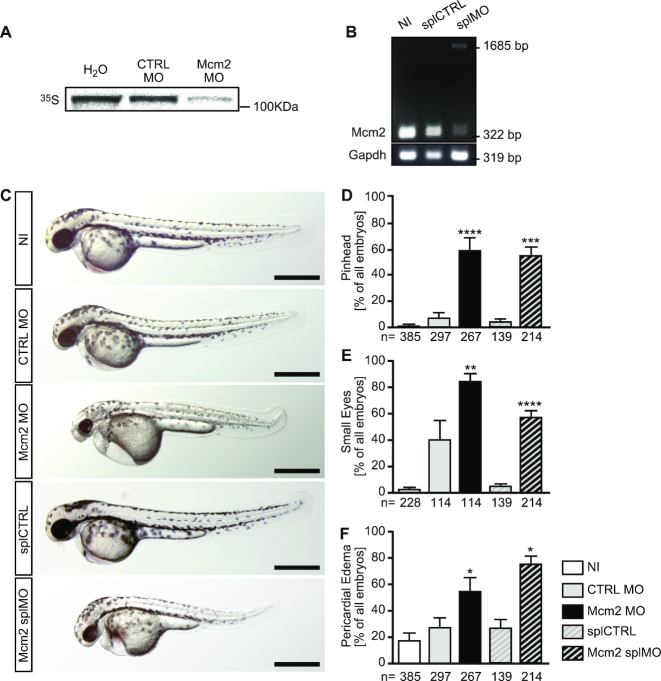
Morphological analysis of zebrafish lacking Mcm2. (A) Autoradiogram to show the binding efficiency of the Mcm2 MO. In vitro translation of Mcm2 was done in the presence of CTRL (CTRL MO) and translation blocking MO (Mcm2 MO) using a cell-free reticulocyte lysate and 35S-labeled methionine. As template, pCS2+ containing parts of the 5′-UTR fused to the ORF of Mcm2 was used. n = 3 MO binding tests (in triplicate). (B) RT-PCR of non-injected (NI), control injected (splCTRL) and splice blocking injected (splMO) embryos at 24 hpf. In embryos with Mcm2 splMO the original band at 322 bp partially disappeared. Instead a second band at 1685 bp could be detected, which contained parts of intron 2. n = 2 independent experiments. (C) Live images of zebrafish at 48 hpf. Scale bars: 500 μm. (D) Mcm2 depleted embryos develop smaller anterior structures. Numbers of embryos analysed are given below the bars. 3–10 independent experiments. **** indicates a P value ≤0.0001, *** means P ≤ 0.001. One-way ANOVA with Sidak's multiple comparison test. (E) Loss of Mcm2 impairs eye development. Numbers of embryos analysed are given below the bars. 3–6 independent experiments. **** indicates a P value ≤0.0001, ** means P ≤ 0.01. One-way ANOVA with Sidak's multiple comparison test. (F) Zebrafish lacking Mcm2 show a tendency to develop pericardial edema. Numbers of embryos analysed are given below the bars. 3–11 independent experiments. * indicates a P value <0.05. One-way ANOVA with Sidak's multiple comparison test.